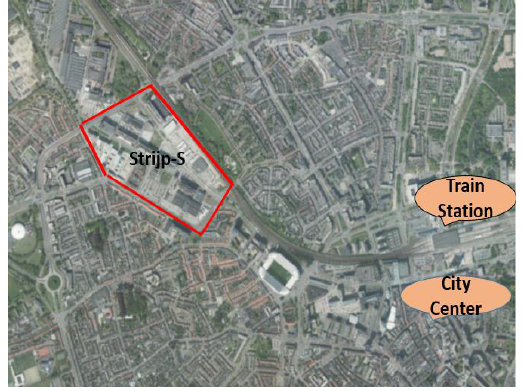
Figure 2 A GIRAPIM CityGML extension (Arroyo, Biljecki, & Diakit, 2017) B New Cultural Heritage CityGML extension